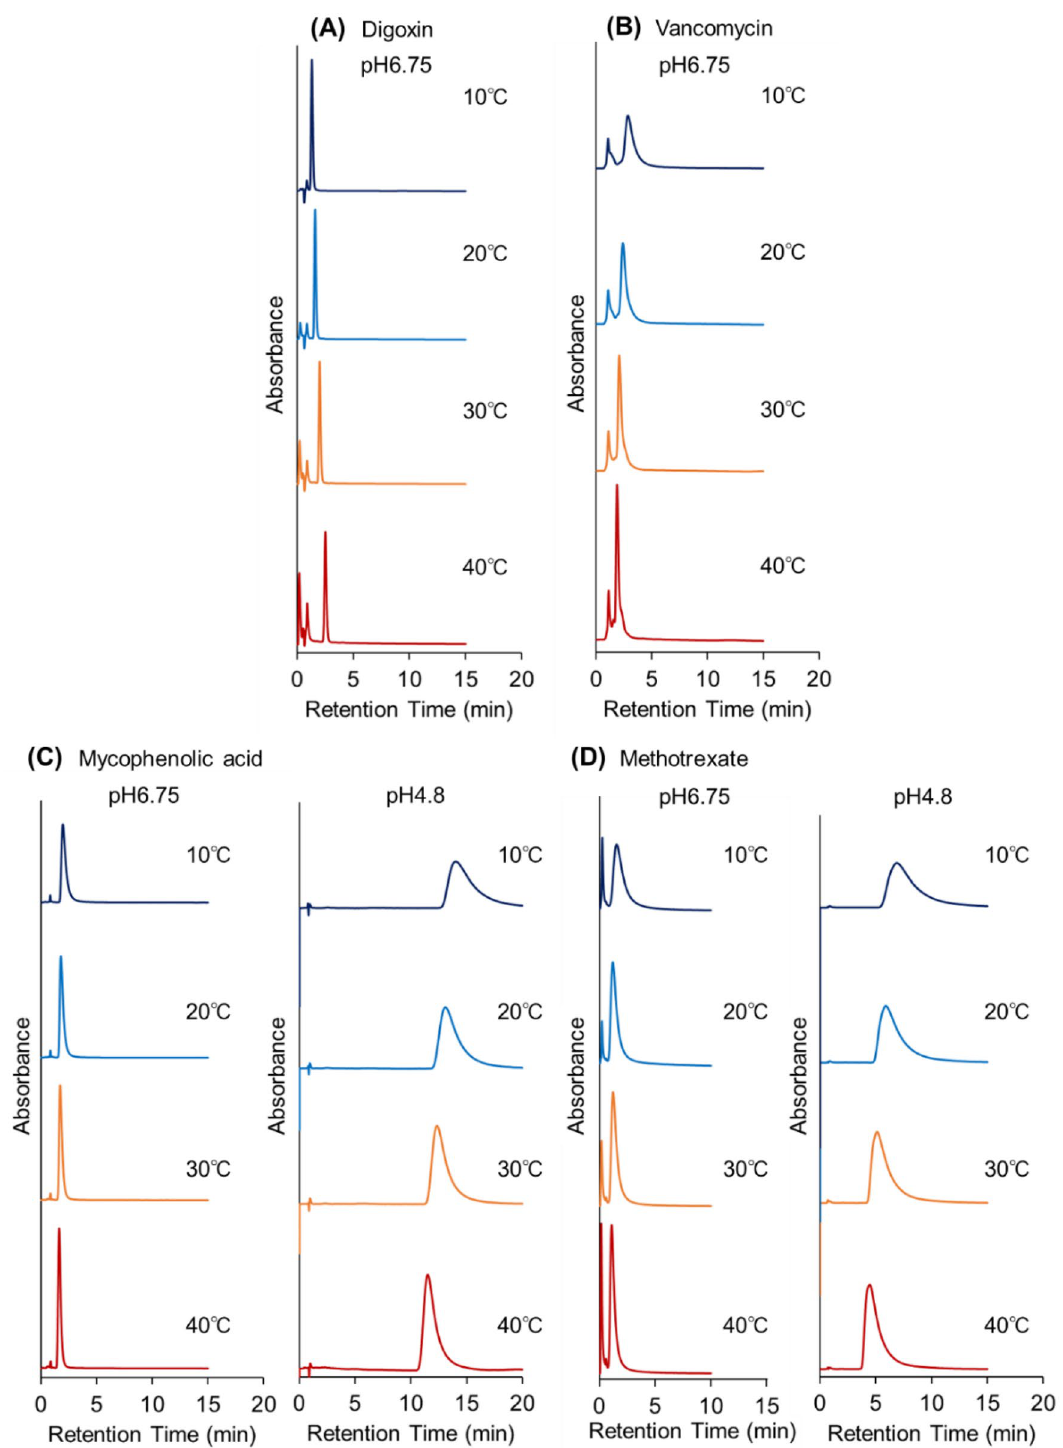
Figure 5. Chromatograms of ( A ) digoxin (cardiac glycoside), ( B ) vancomycin (antibacterial drug), ( C ) mycophenolic acid (immune-suppressing drug), and ( D ) methotrexate (anti-cancer drug) using crosslinked PNIPAAm modified-bead packed columns. Mobile phases were 10 mM CH 3 COONH 4 (pH 6.75) buffer solution and 10 mM